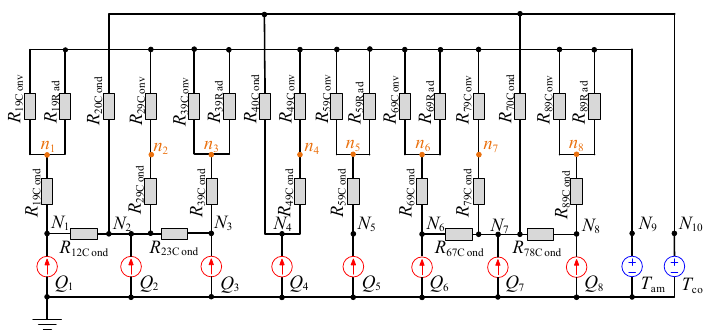
Figure 17. Thermal network model of the CW ELII MFT.